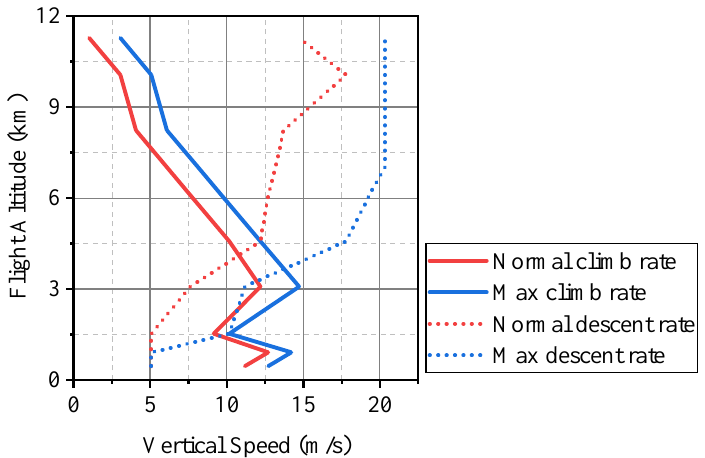
Figure 6. Climb and descent rates for aircraft A320 in the ISA condition.